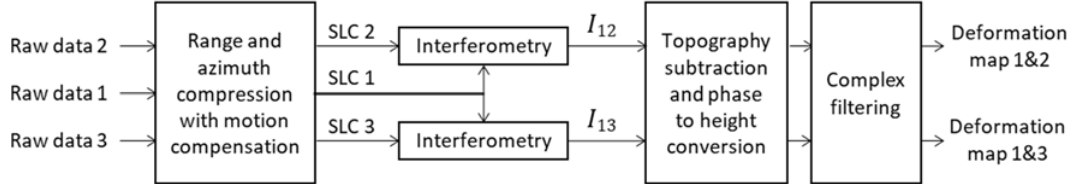
Figure 3. Simplified flow chart of the processing chain. The complete version is in [10]. I 12 is the interferogram 1 and 2, and I 13 is the interferogram 1 and 3. The chosen processing chain [10] was originally applied to an airborne DInSAR experiment.